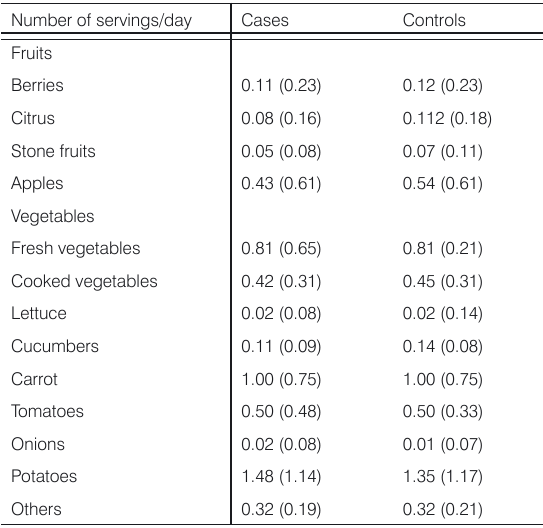
Table 2. Consumption of fruits and vegetables (median number of servings/day with interquartile range) grouped by cases and controls.